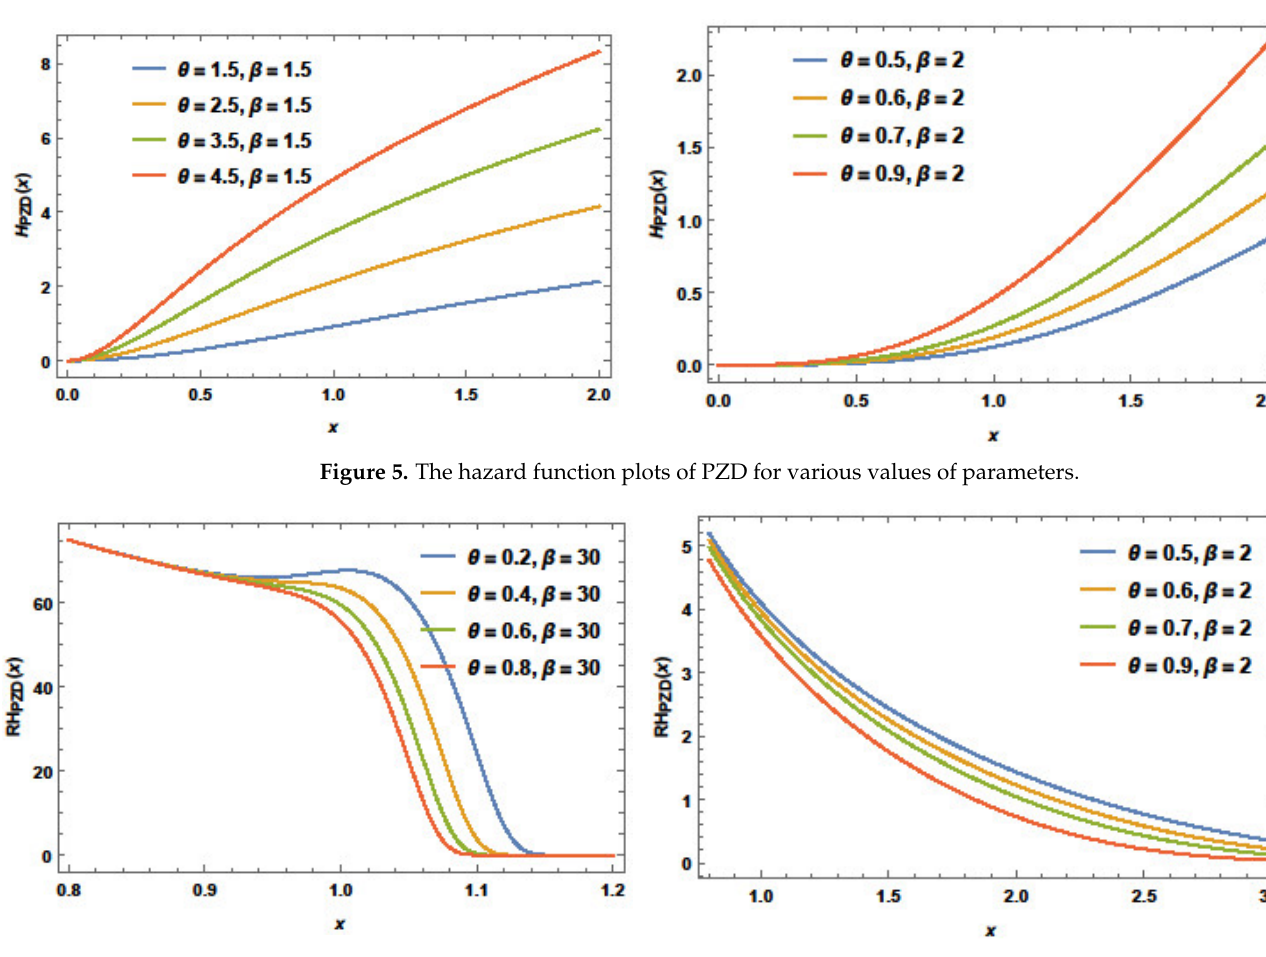
Figure 6. The RHF plots of PZD for various values of parameters.